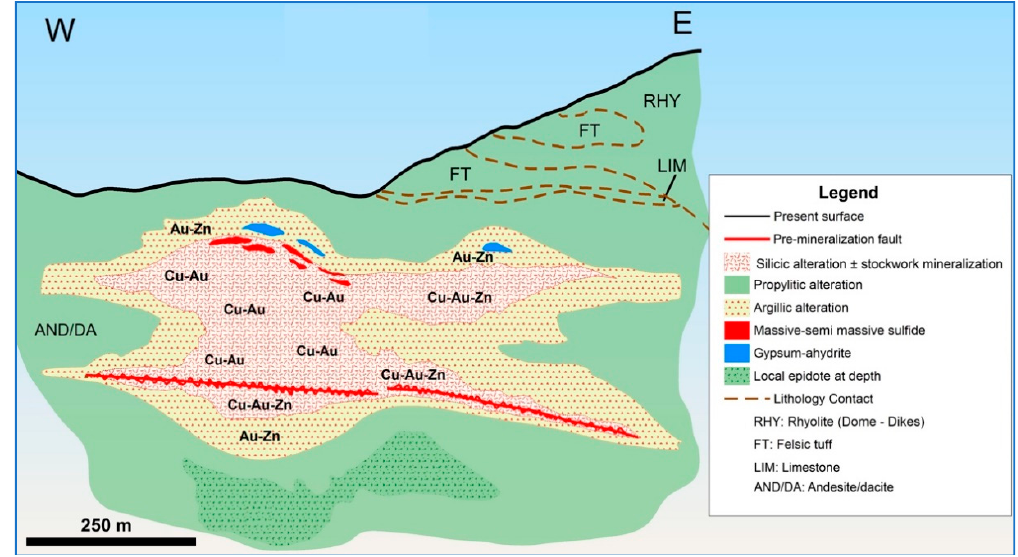
Figure 3. Schematic cross section showing the key geologic elements of the Romero deposit. Post-mineralization faults have been removed to facilitate the comprehension of the figure.